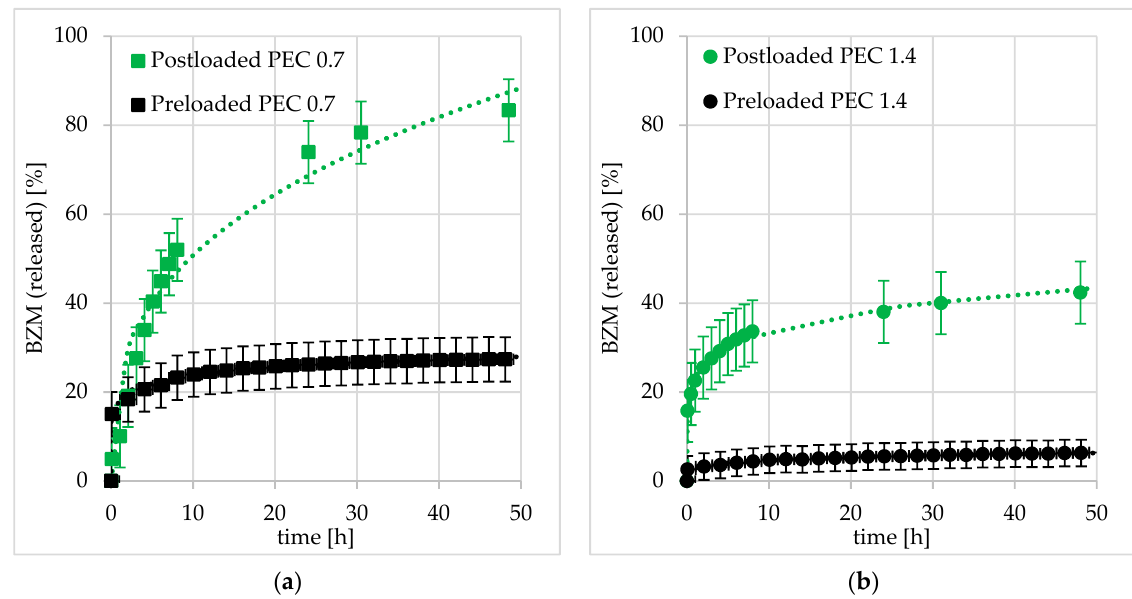
Figure 15. Release kinetics of BZM from ( a ) positively charged PEC 0.7 and ( b ) negatively charged